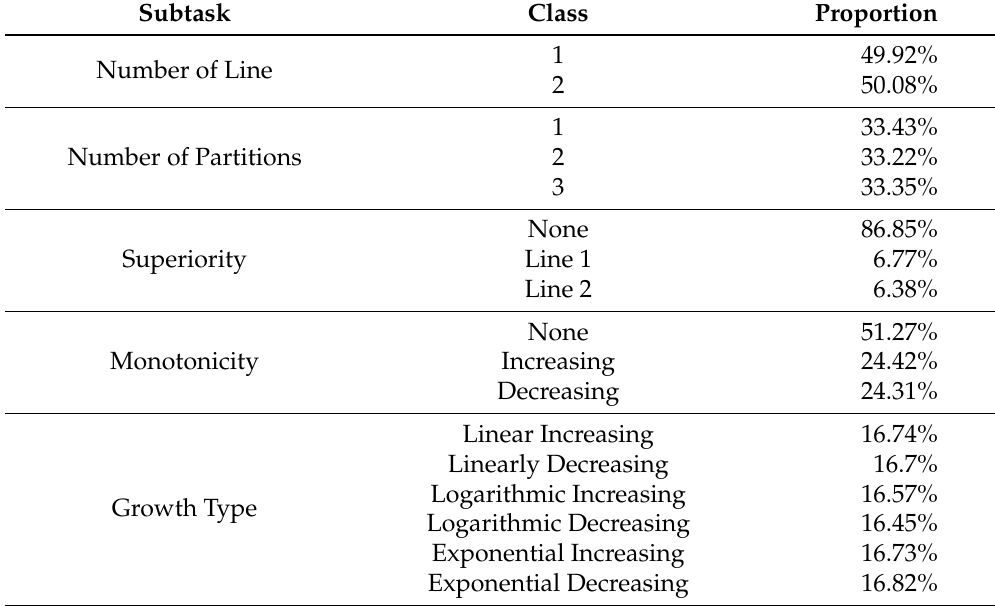
Table 3. Proportion of labels in training